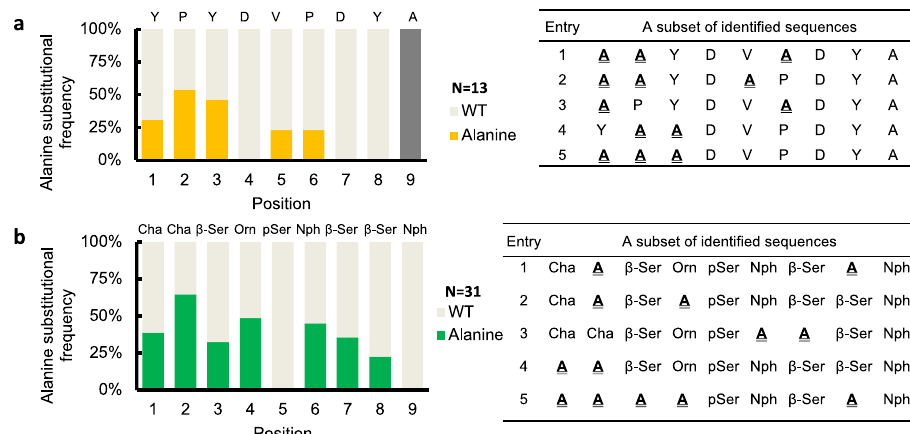
Fig. 6 Combinatorial alanine scanning is applicable to peptide binders for antibody 12ca5 and regulatory protein 14-3-3 σ . a Alanine substitution frequency at each position of the 12ca5 binder HA epitope (sequence: YPYDVPDYA). b Alanine substitution frequency at each position of the protein 14-3- 3 σ binder 14-3-3.6 construct (sequence: Cha-Cha- β -Ser-Orn-pSer-Nph- β -Ser- β -Ser-Nph); abbreviations: Cha cyclohexyl alanine, β -Ser beta-homoserine, Orn ornithine, pSer phosphoserine, Nph 4-nitro phenylalanine. Wild-type alanine is excluded from the